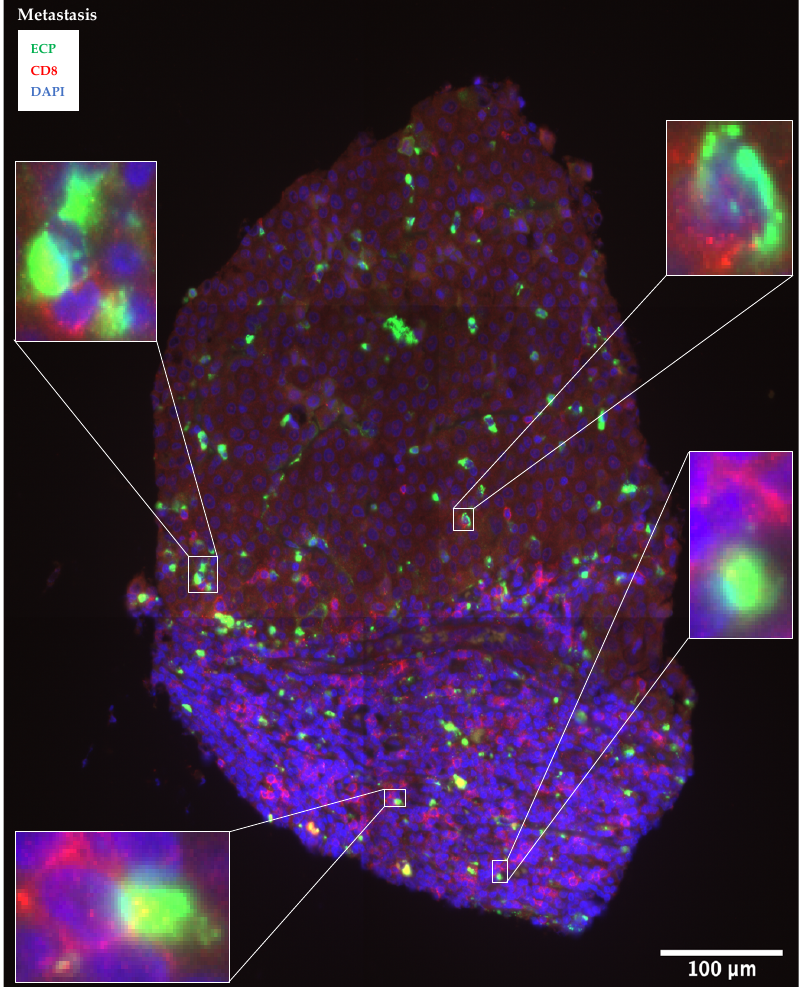
Figure 3. Melanoma metastasis with a high contiguous infiltration of ECP expressing eosinophils and CD8 expressing effector T-cells. Paraffin-embedded tissue samples of a metastasis are co-stained with immunofluorescent anti-ECP antibodies (marked green) and anti-CD8 antibodies (marked red). Nuclei were stained in blue with DAPI. Abbreviations: ECP: eosinophil cationic protein; CD: cluster of differentiation; DAPI = 4 (cid:48)